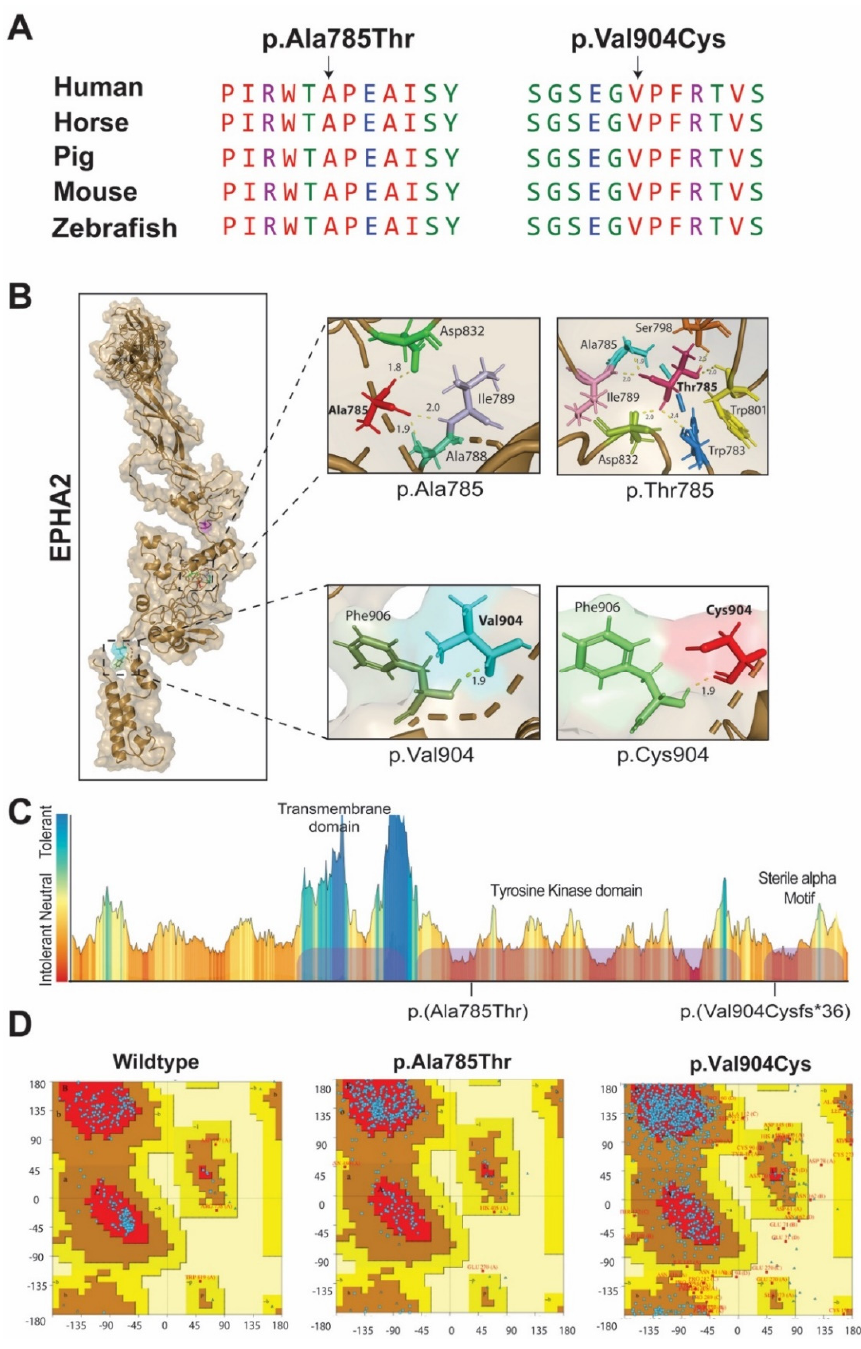
Figure 2. Protein modeling and bioinformatic analysis of identified variants of EPHA2. ( A ) Multiple sequence alignment of EPHA2 shows that all three residues are conserved across various vertebral species. ( B ) 3D Protein modeling of EPHA2 showing that wildtype and mutated residue of EPHA2 at position 904 do not depict any differences in bonding with neighboring residues, but mutated residue at position 785 is showing three extra hydrogen bonding with neighboring residues. ( C ) MetaDome health map shows that EPHA2 residue at position 785 and 904 are present in highly intolerant region. ( D ) Ramachandran plots for wildtype and mutated residues of EPHA2 revealed that as compared to 94.1% of the residue found in the allowed region for WT protein, 86.7% (EPHA2 p.Thr785 ) and 67.6% (EPHA2 p.Cys904 ) of the residues were present in allowed region for the EPHA2 harboring identified variant.